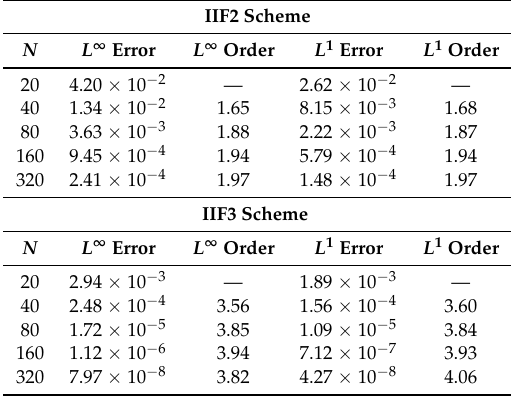
Table 1. Example 1: Cahn–Hilliard equation. Numerical errors and orders of accuracy of the